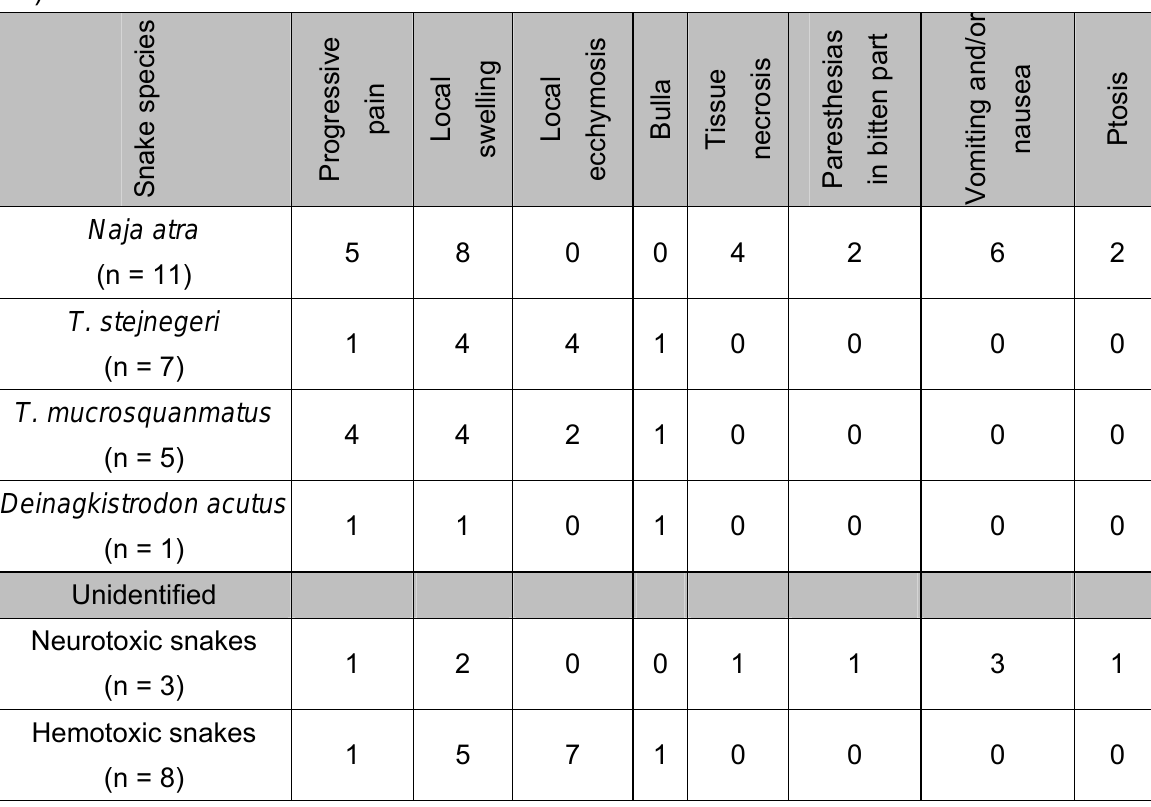
Table 2. Symptoms and signs of envenomated patients on hospital presentation (n =